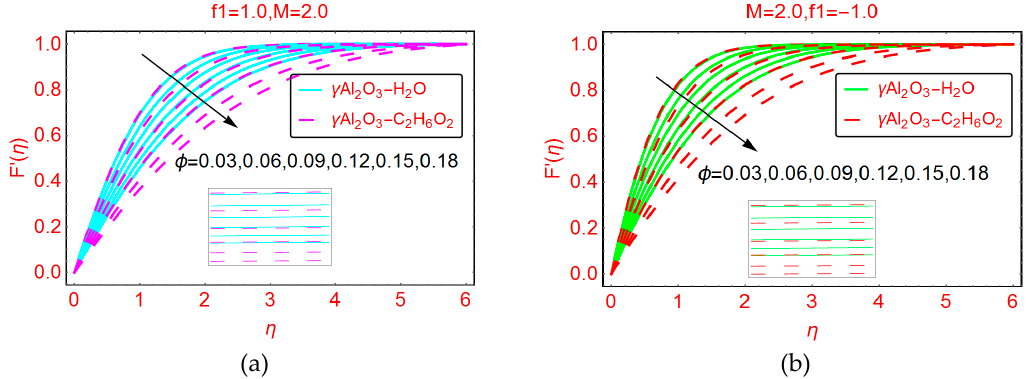
Figure 4. E ff ects of φ on the velocity profile F (cid:48) ( η ) for ( a ) f 1 = 1.0 and ( b ) f 1 = − 1.0.